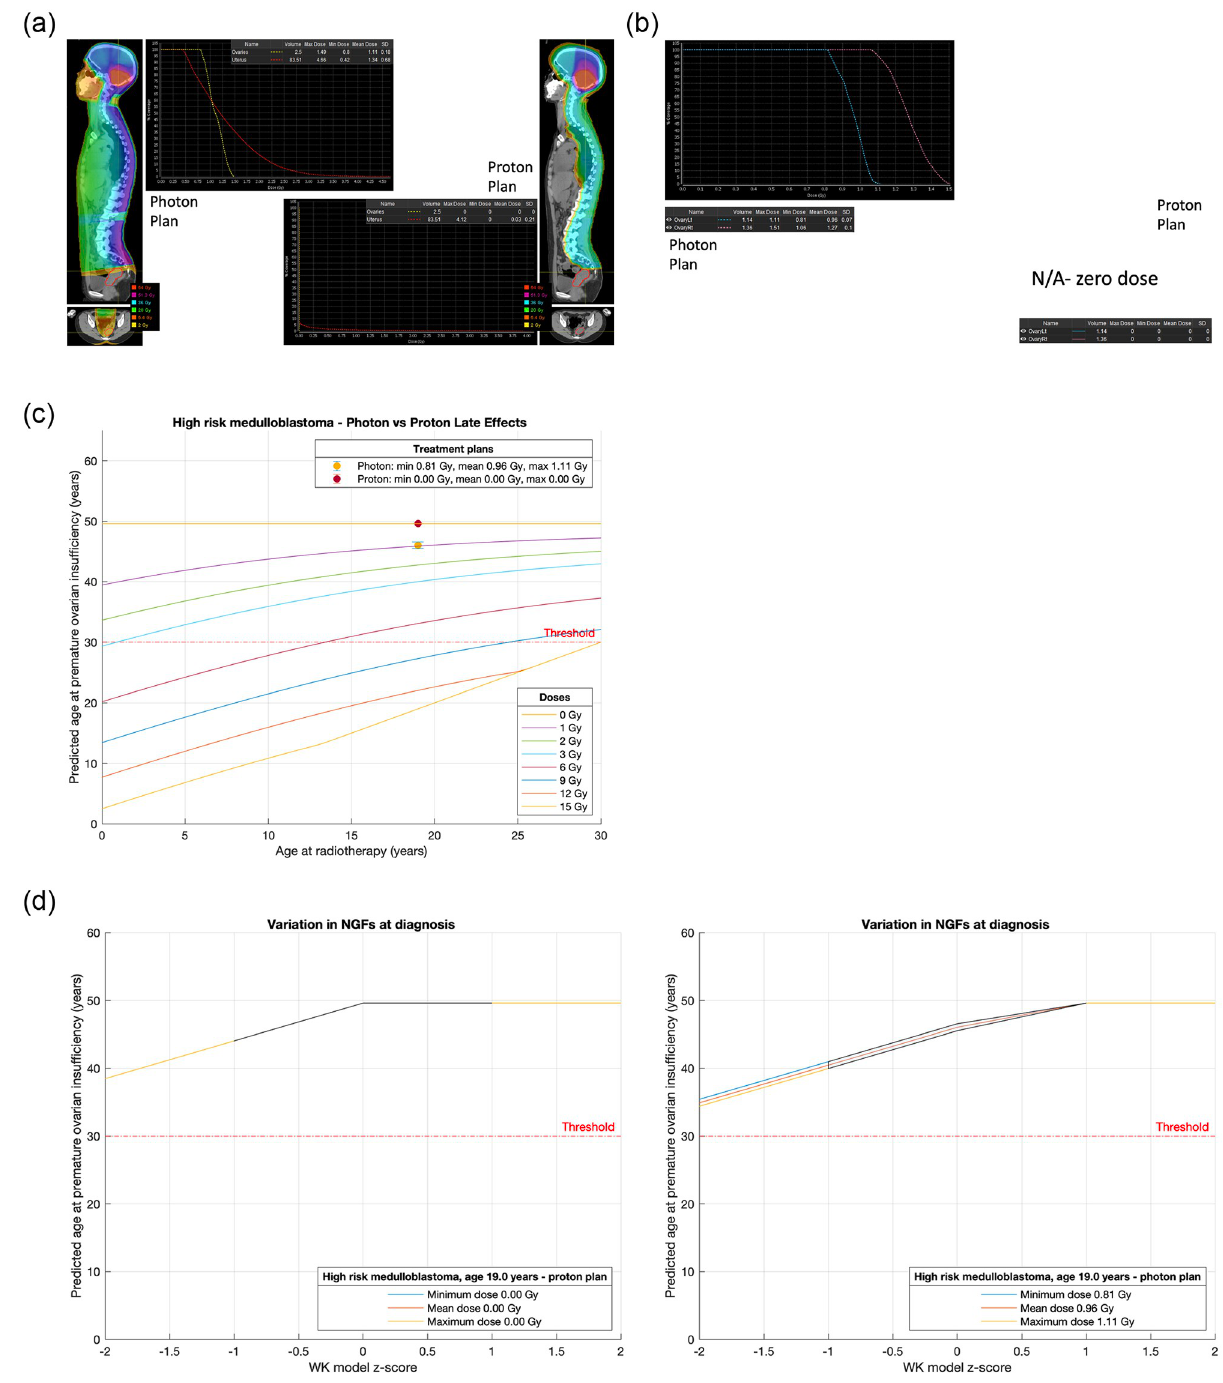
Fig 5. a . Treatment plans for Case 2, a 19-year-old with high risk medulloblastoma. b . Analysis and comparison of dose received by each ovary for Case 2, a 19-year-old with high risk medulloblastoma. c . Comparison of treatment plans assuming average NGF population at age of treatment (i.e., z- score = 0) for Case 2, a 19-year-old with high risk medulloblastoma. Dots are predicted age at menopause after mean dose. Fertility window ranges between predicted ages for minimum & maximum dose. LD 50 is estimated to be 2 Gy. Dose is to the least affected ovary. d . Comparison of treatment plans for Case 2, a 19-year-old with high risk medulloblastoma that incorporate uncertainty due to variation in NGF population at birth. (Or, equivalently, variation in ages at menopause). The z-score 0 values are the same ranges as reported in Fig 6. 68% of the population are expected to fall in the left-to-right shaded